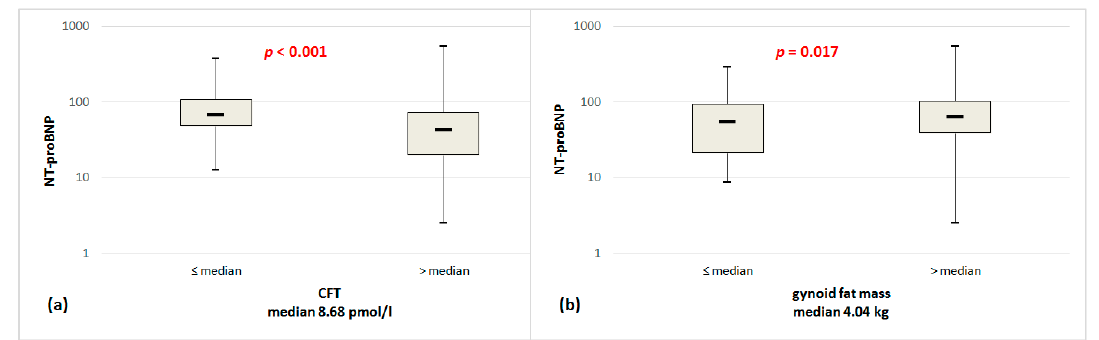
Figure 2. NT-proBNP serum levels in a population stratified by CFT ( a ), gynoid fat mass ( b ) on a